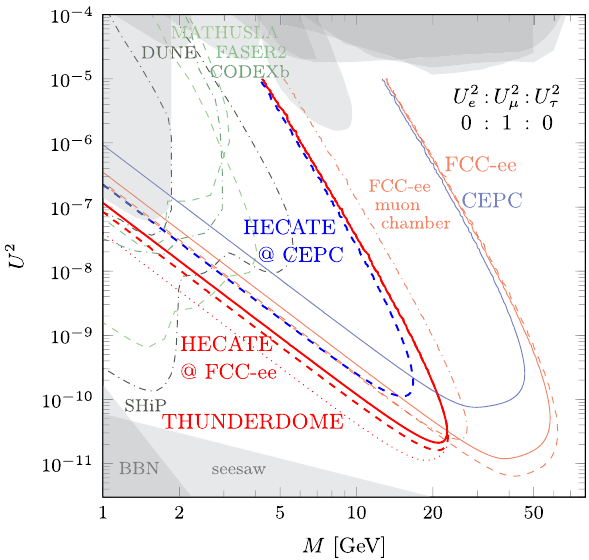
Fig. 1 Comparison of the sensitivities for nine signal events that can be achieved at the FCC-ee with 2 . 5 × 10 12 Z -bosons (red) or CEPC with 3 . 5 × 10 11 Z -bosons (blue). The faint solid curves show the main detector sensitivity ( l 0 = 5mm, l 1 = 1 . 22m). The faint dash-dotted curve indicates the additional gain if the muon chambers are used at the FCC-ee ( l 0 = 1 . 22m, l 1 = 4m). The thick curves show the sensitivity of HECATE with l 0 = 4m, l 1 = 15m (solid) and l 0 = 4m, l 1 = 25m (dashed), respectively. Finally, the faint dashed red line shows the FCC- ee main detector sensitivity with 5 × 10 12 Z -bosons, corresponding to the luminosity at two IPs. For comparison we indicate the expected sensitivity of selected other experiments with the different green curves as indicated in the plot [8–10,45,48]. The gray areas in the upper part of the plot show the region excluded by past experiments [49–57], the grey areas at the bottom mark the regions that are disfavoured by BBN and neutrino oscillation data in the ν MSM (‘seesaw’)